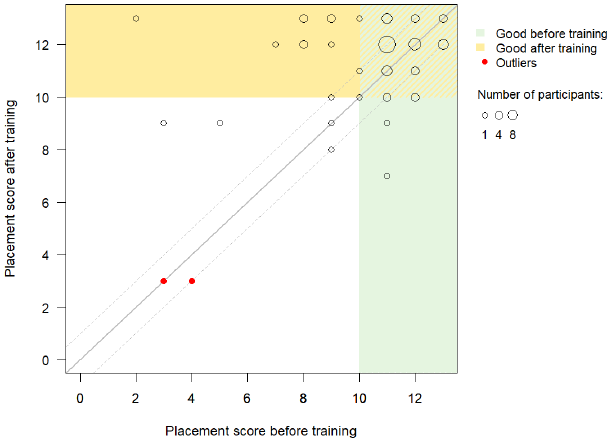
Figure 6. Placement scores before the training ( x axis) and after the training ( y axis). The circle size indicates the number of participants with the same scores. The green background indicates participants who had already performed well in placing the staff gauge before the training (score ≥ 10), and the yellow background indicates par- ticipants who performed well after the training (score ≥ 10). The solid grey line indicates the 1 : 1 line (i.e., the same score before and after the training), while the dashed lines indicate a difference of only one point. Points in the upper-left triangle indicate an im- provement in staff gauge placement after the training. The red cir- cles indicate outliers.